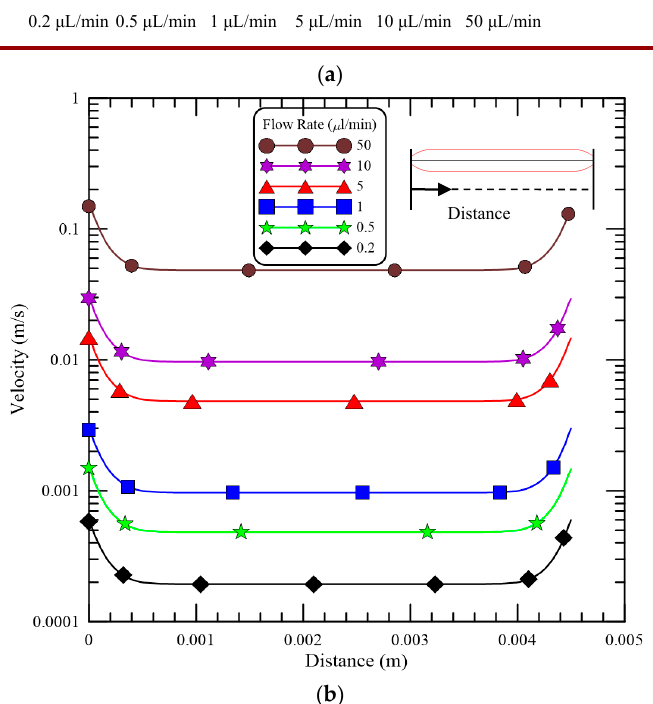
Figure 4. ( a ) The cross-sectional temperature distributions at the Y-half cut cross section of the channel and ( b ) the velocity profiles along the central line at the enlarged part of the channel for different flow rates.